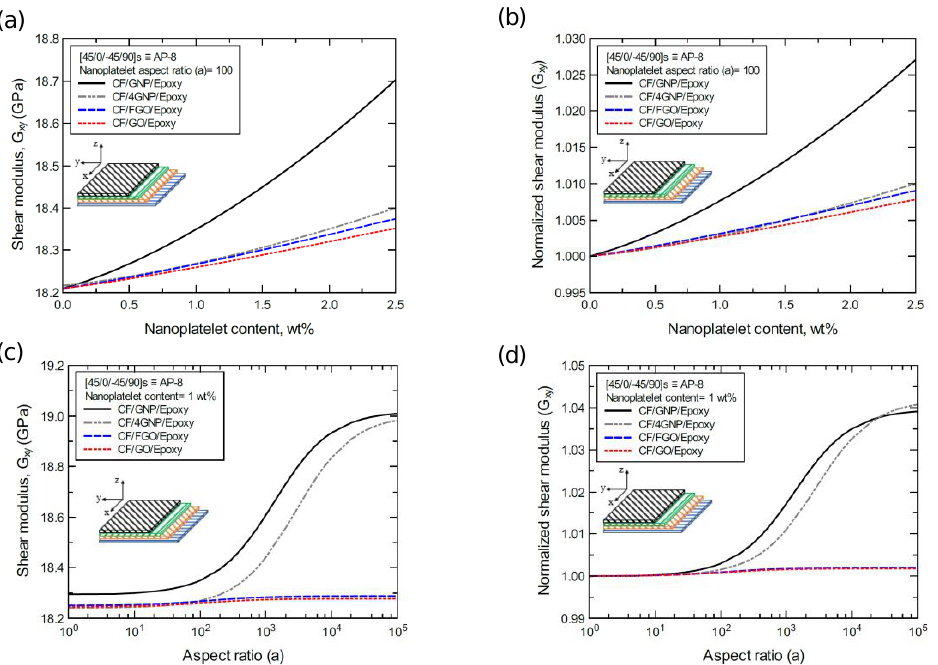
Figure 22. Comparison of the predicted in-plane shear modulus (G xy ) for a [45/0/-45/90]s (AP-8)-laminated composite plate based on the nanoplatelet type, content, and aspect ratio; ( a ) predicted G xy for various nanoplatelet contents at 100 aspect ratio, and the normalized response is shown in ( b ); ( c ) predicted G xy for various aspect ratio values at 1.0 wt% nanoplatelet content, and the normalized response is shown in ( d ). The volume fraction of CF is 56%.